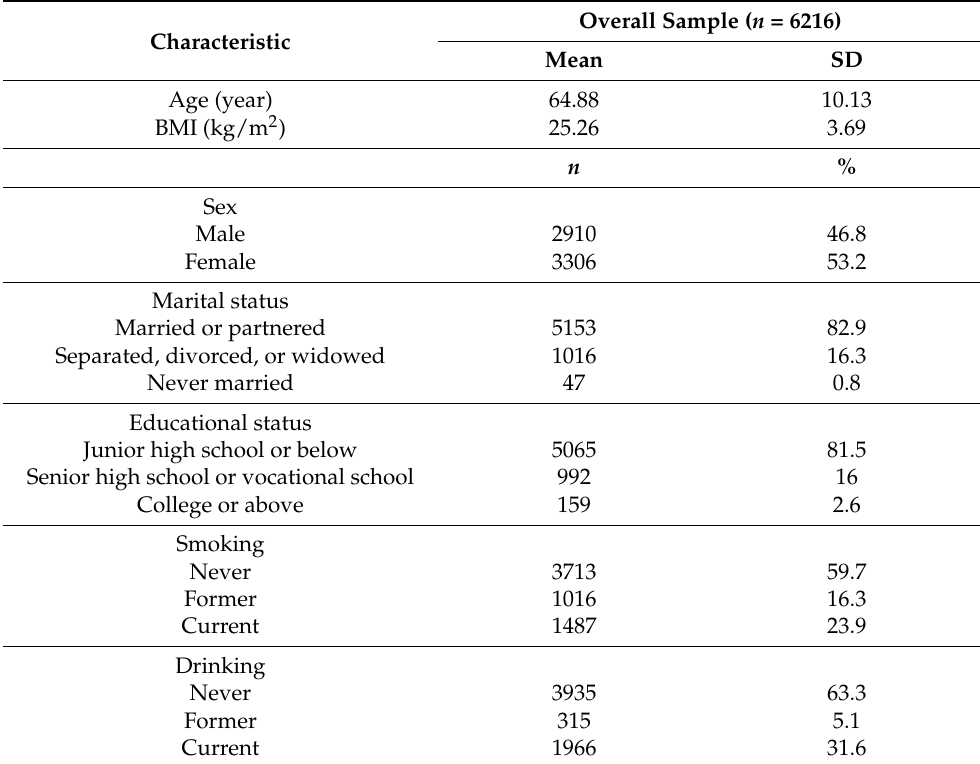
Table 1. Basic characteristics of